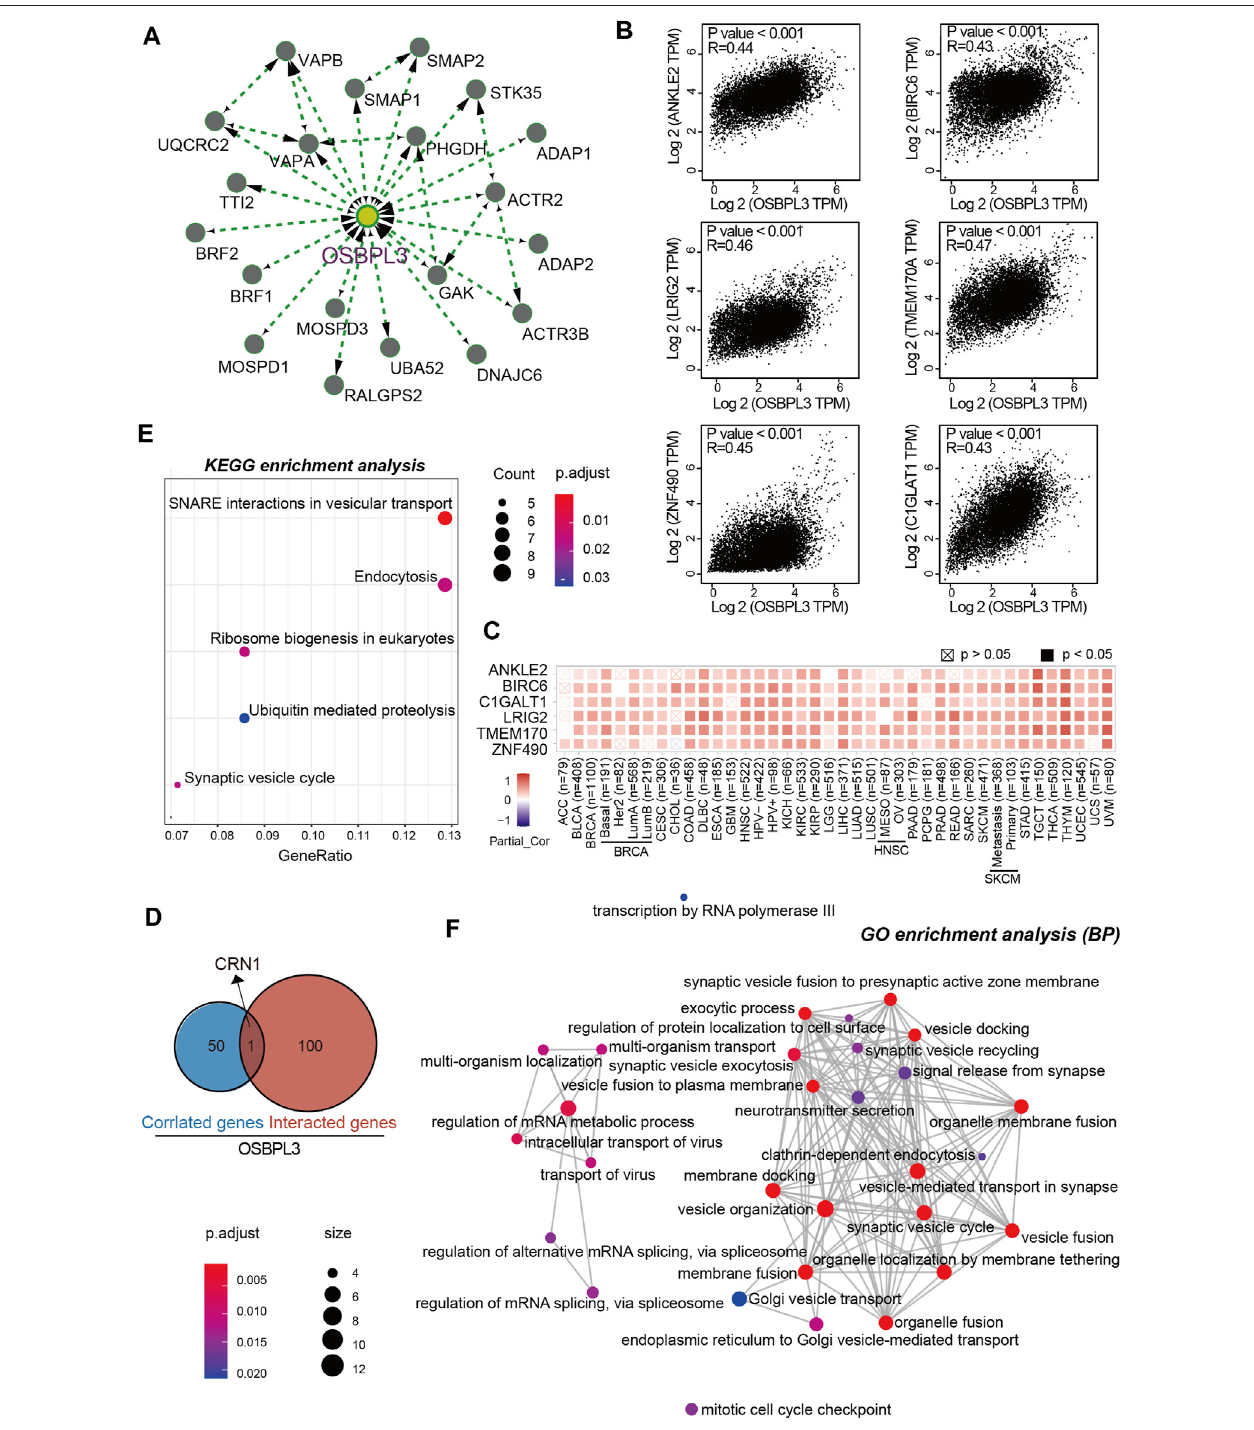
FIGURE12| OSBPL3-relatedgeneenrichmentanalysis. (A) Thetop20availableexperimentally determined OSBPL3-bindingproteins using theSTRING tool. (B) Thetop100OSBPL3-correlatedgenesinTCGAprojectsonGEPIA2andexpressioncorrelationbetweenOSBPL3andtopsixgenes,includingANKLE2,BIRO6,LRIG2, TMEM170A,ZNF490,andC1GLAT1. (C) Heatmap ofcorrelationbetweenOSBPL3andtopsixgenesindifferentcancertypes. (D) AnintersectionanalysisofOSBPL3- binding and -correlated genes. (E – F) KEGG pathway analysis (E) and GO enrichment analysis-biological process (BP) (F ) of the OSBPL3-binding and -interacted genes were